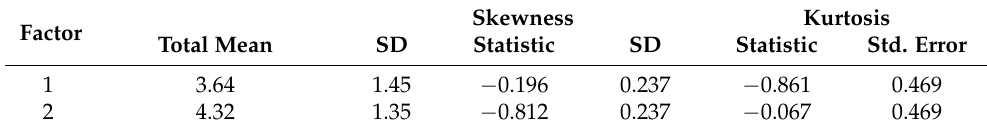
Figure 2. Scree plot representing the eigenvalues (6-item FAS). Pearson’s correlation between Factor 1 and Factor 2 was significant ( r = 0.48; p < 0.001) and above the recommended value ( r ≥ 0.30). The 6-item scale presented a mean for the overall tool of 24.57 (SD = 7.27) and an item’s mean of 4.09 (SD = 1.21). Moreover, Factor 1 had a mean of 17.29 (SD = 5.41), and Factor 2 had a mean of 7.29 (SD = 2.91) (Table